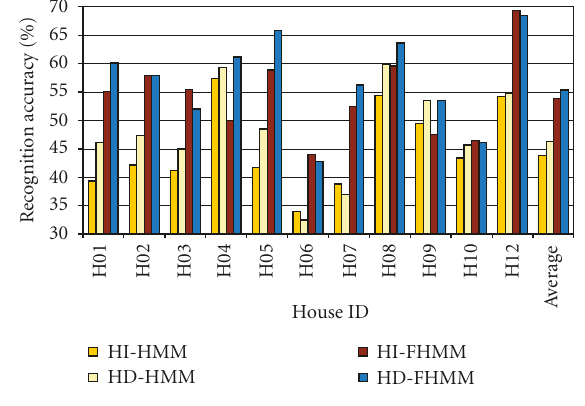
Figure 9: Results for unsupervised adaptation.